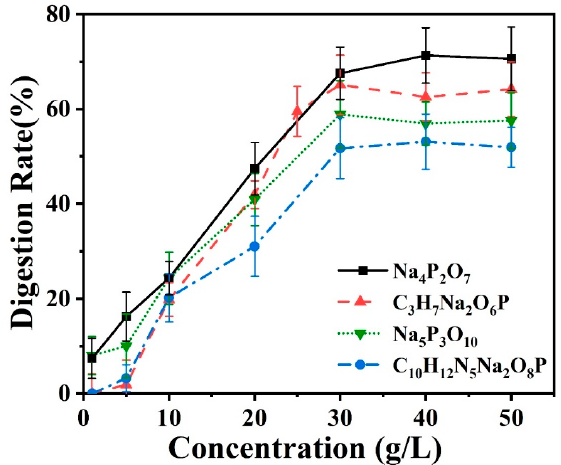
Figure 5. Online measurement of the digestion efficiency of four kinds of phosphate solution samples at different temperatures; the concentration of K 2 SO 4 was prepared as 50 g/L and the pH value was 11.4.